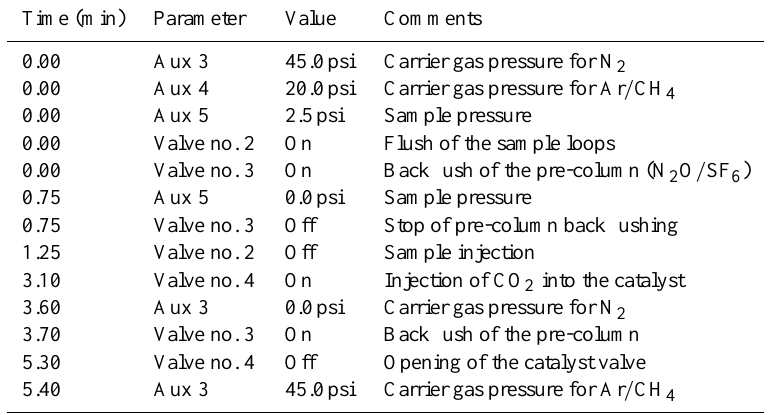
Table 1. Measurement method used for the GC system at the Puy de Dôme station. The “On” position on the valves presented here corre- sponds to the dashed lines in Fig. 2 and the “Off” position correspond to the solid lines.